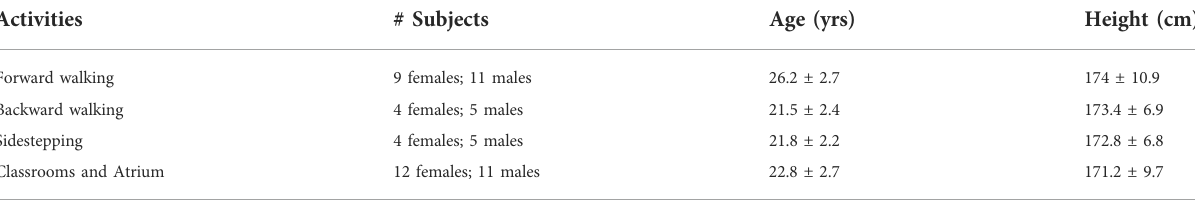
Table 1) full body kinematics dataset that captures